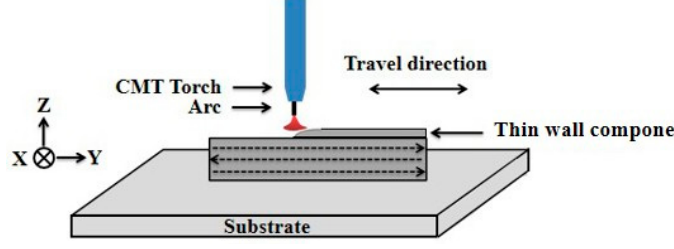
Figure 1. A schematic diagram for the experimental procedure.